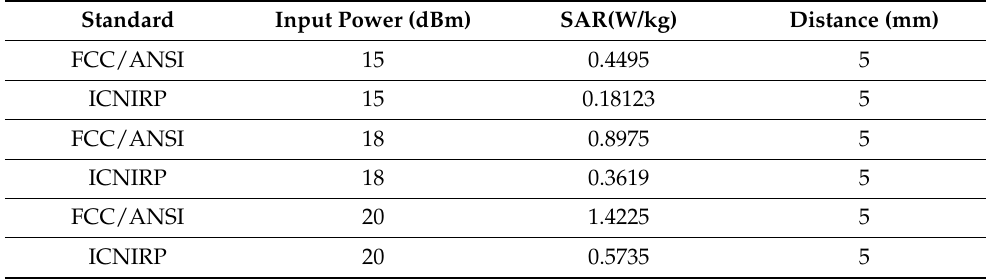
Figure 16. The SAR of the DRA array for a 10-gram tissue and input power of ( a ) 15 dBm, ( b ) 18 dBm, ( c ) 20 dBm. Table 4. The average SAR for 1-gram and 10-gram tissues using input power of 15 dBm, 18 dBm and 20